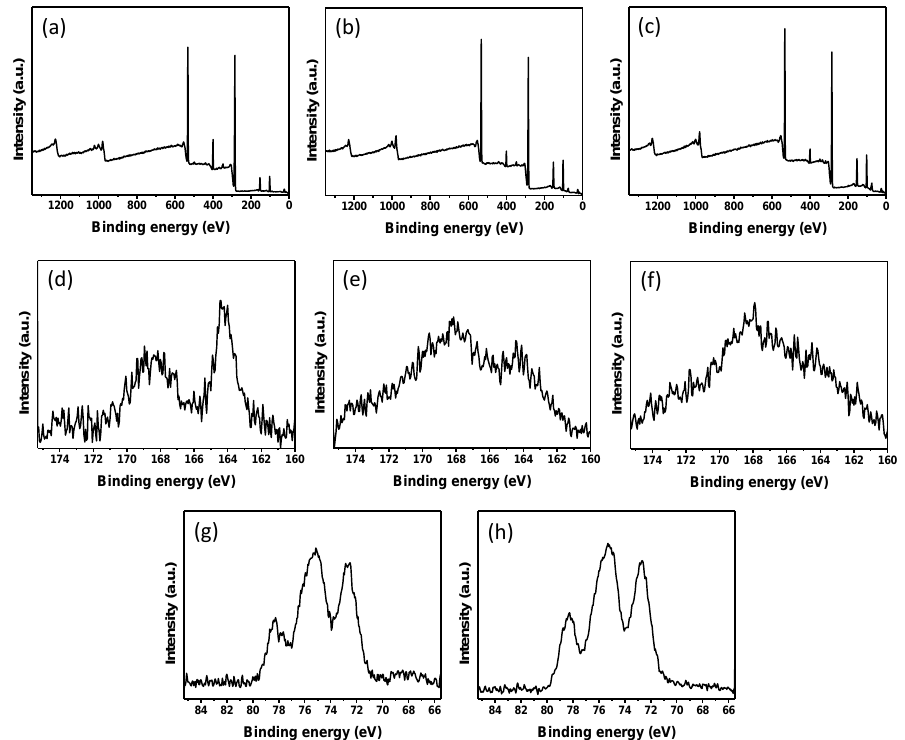
Figure 3. X-ray photoelectron spectroscopy (XPS) spectra of ( a ) the pristine silk fabric; ( b ) PSF2 and ( c ) PSF4. S 2p XPS spectra of ( d ) the pristine silk fabric; ( e ) PSF2 and ( f ) PSF4. Pt 4f XPS spectra of ( g ) PSF2 and ( h ) PSF4.